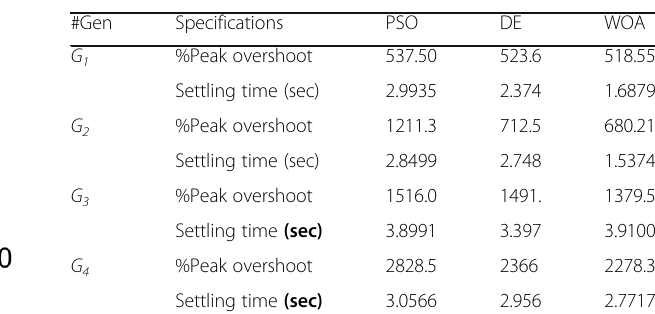
Table 7 Time response specifications of two area system